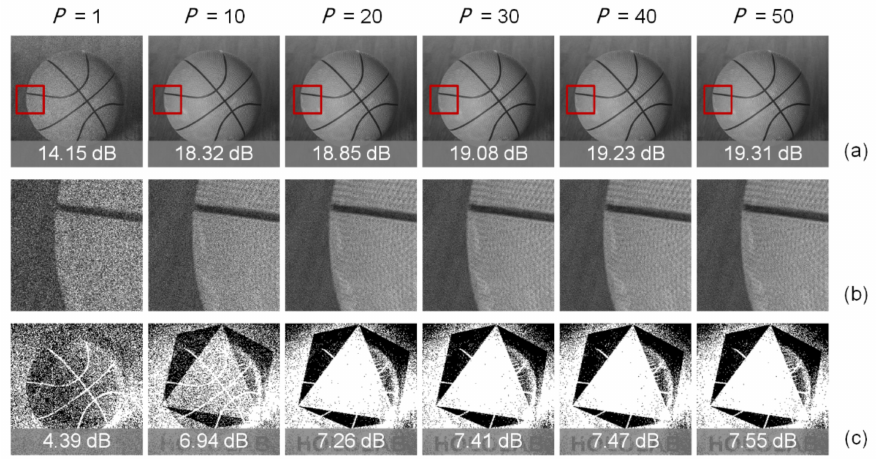
Figure 10. ( a ) Holographic reconstructions under different iteration numbers. ( b ) Locally enlarged results of holographic reconstructions. ( c ) The extracted watermarks from the reconstructions.